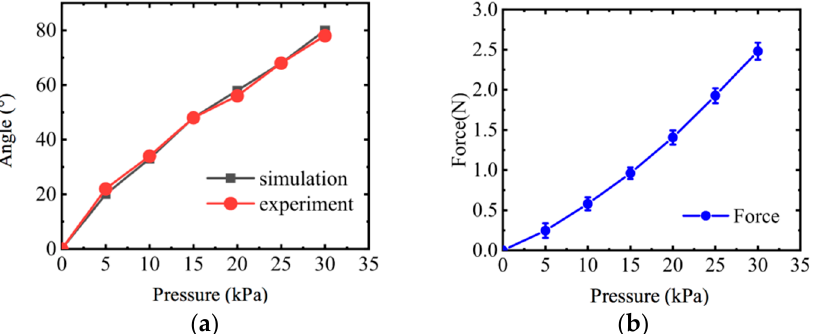
Figure 17. Angle and force test of actuator for thumb. ( a ) Thumb rotating angle results. ( b ) A curve of force versus pressure.